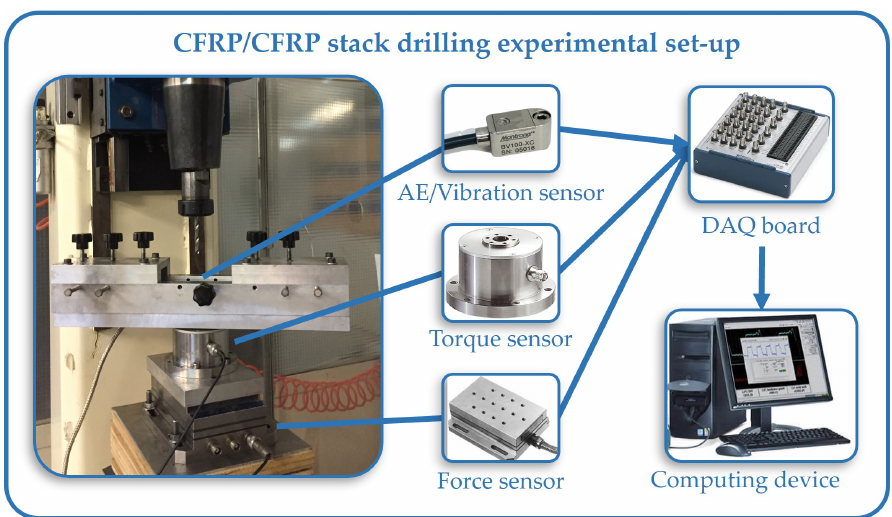
Figure 1. Experimental setup for the CFRP/CFRP stack drilling tests: CNC drill press and sensor monitoring system.